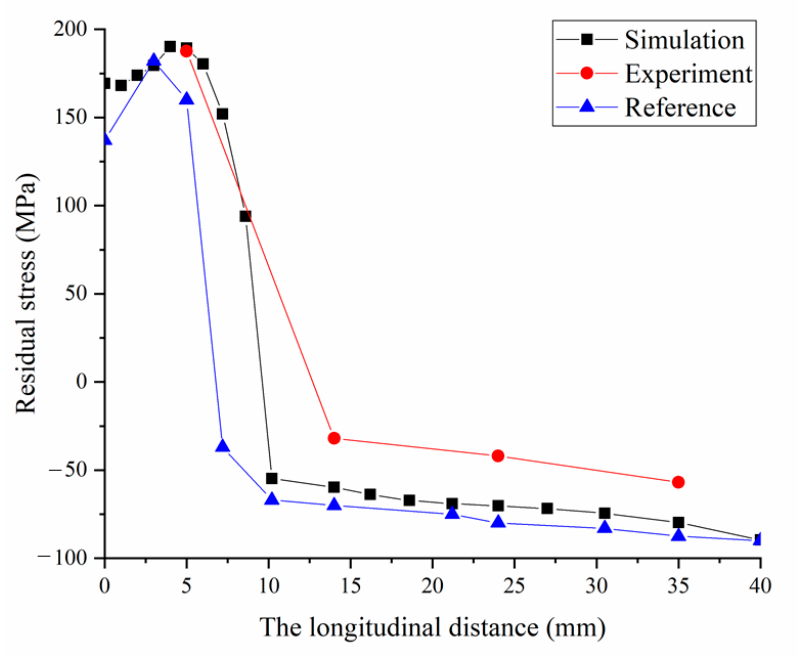
Figure 6. Comparison of simulated and experimental results of welding stress of a T-joint.